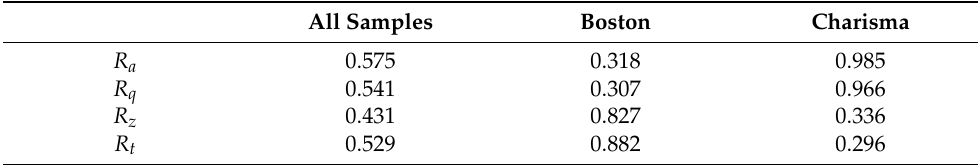
Table 4. Results of Repeated-measures Analysis of Variance for Profilometric Parameters in the Individual Polishing Steps Depending on the Press-on Force ( p -values). All Samples Boston Charisma R a 0.575 0.318